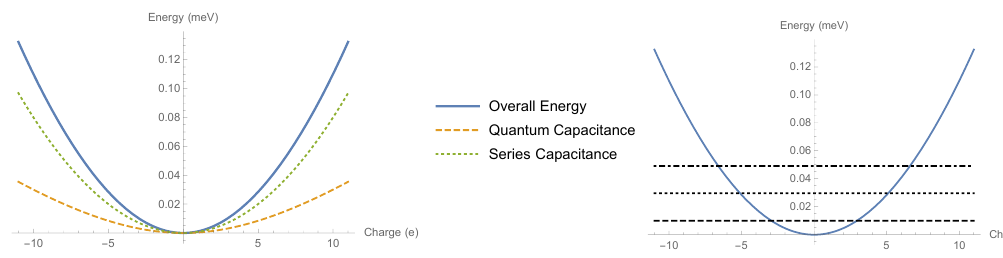
Figure 4. Calculation of energy levels of the anharmonic oscillator composed of nonlinear quantum capacitor and linear inductor shown in Figure